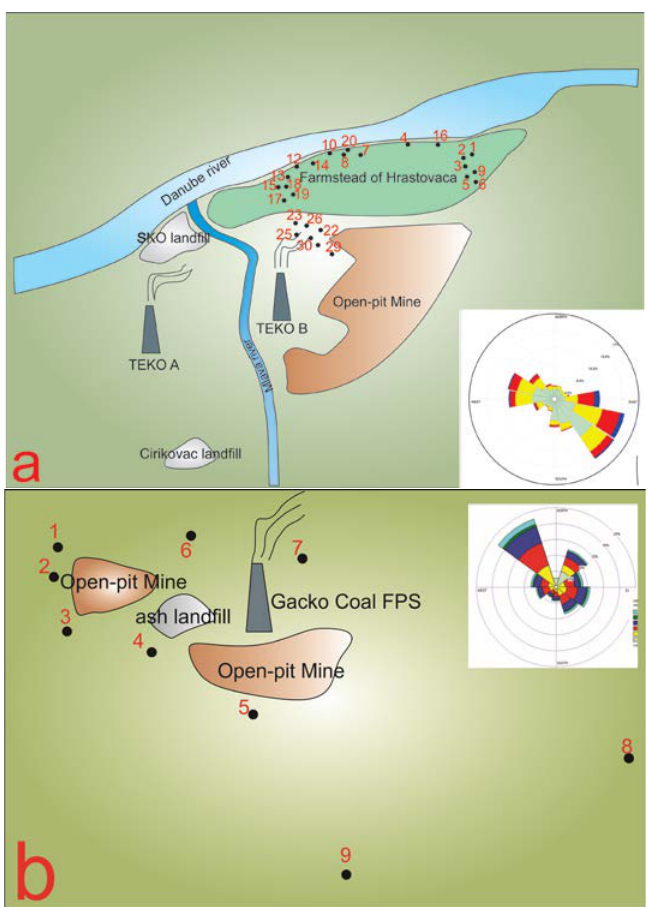
Figure 2. The locations of soil samples collected in the vicinity of Kostolac coal basin ( a ) and Gacko coal basin ( b